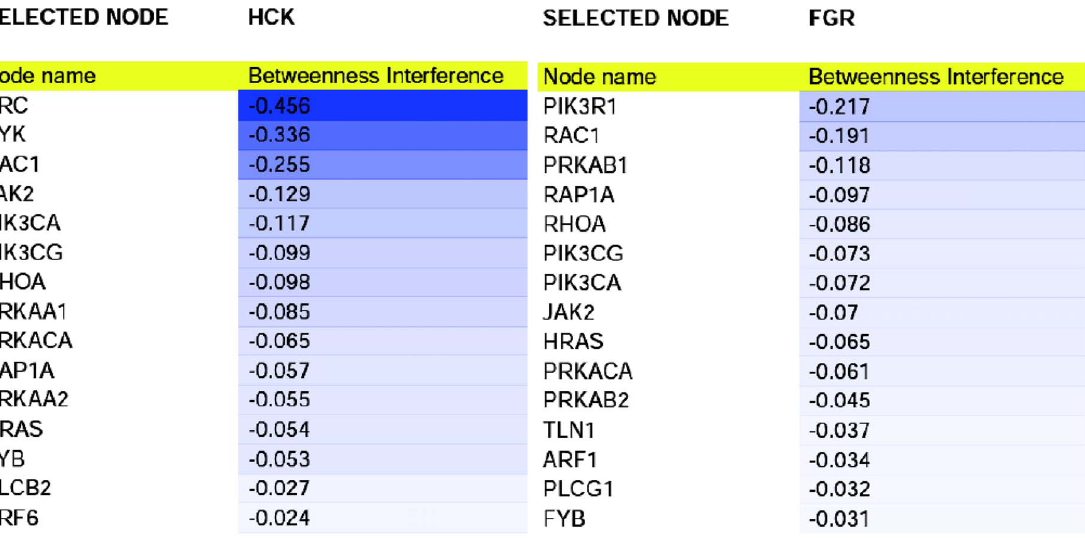
Figure 4. Interference of HCK and FGR. First fifteen negative interference values of HCK and FGR, expressed as percentage.